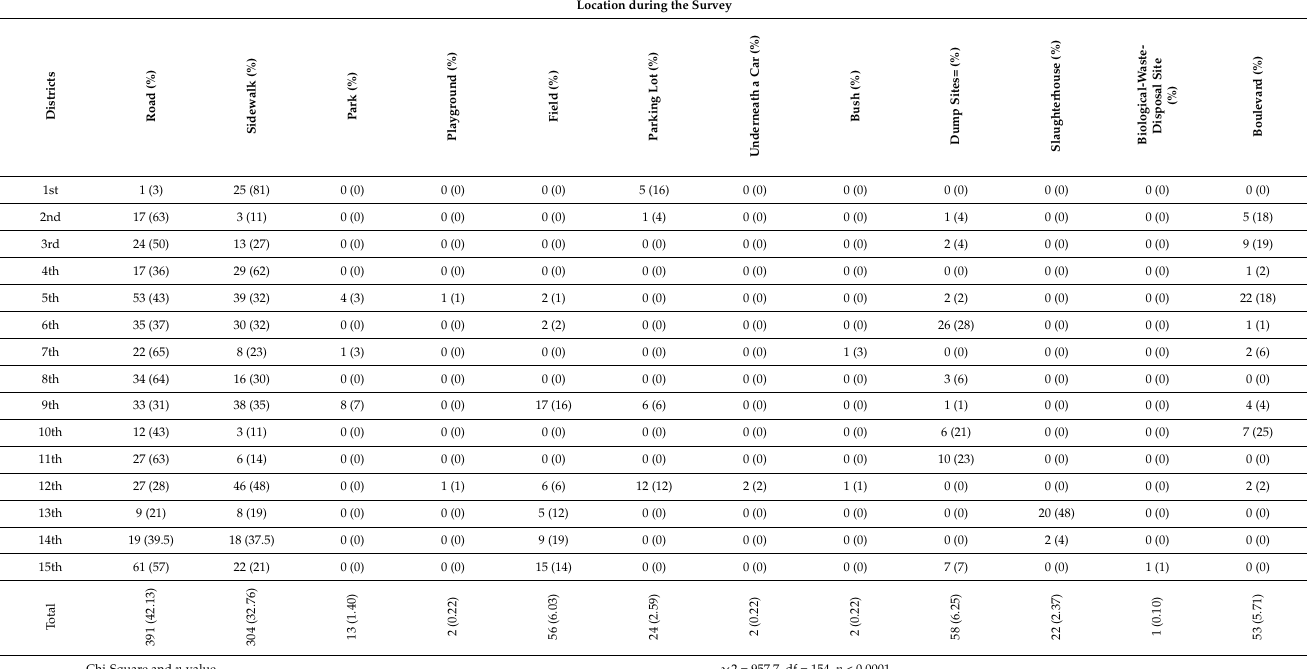
Table 2. Details of locations FRDs were sighted during the survey in each district of Herat city . Location during the Survey